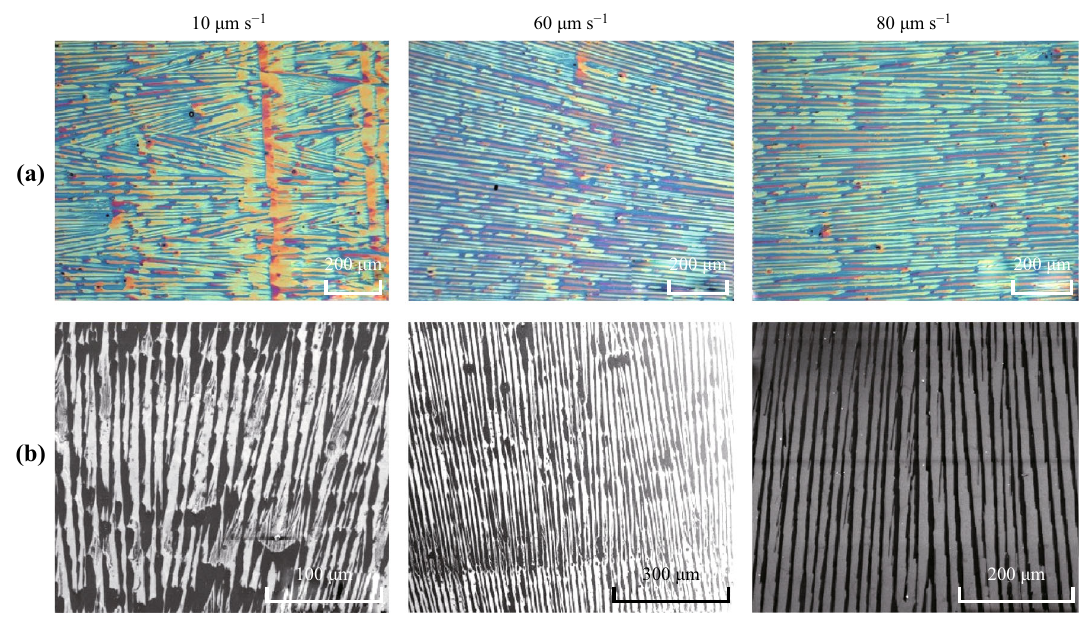
Fig. 4 Bright-field optical microscope images ( a ) and the corresponding SEM images ( b )of TIPS-PEN nanoribbon arrays on the SiO 2 /Si substrate formed at coating speeds of 10, 60, and 80 l m s - 1 , respectively